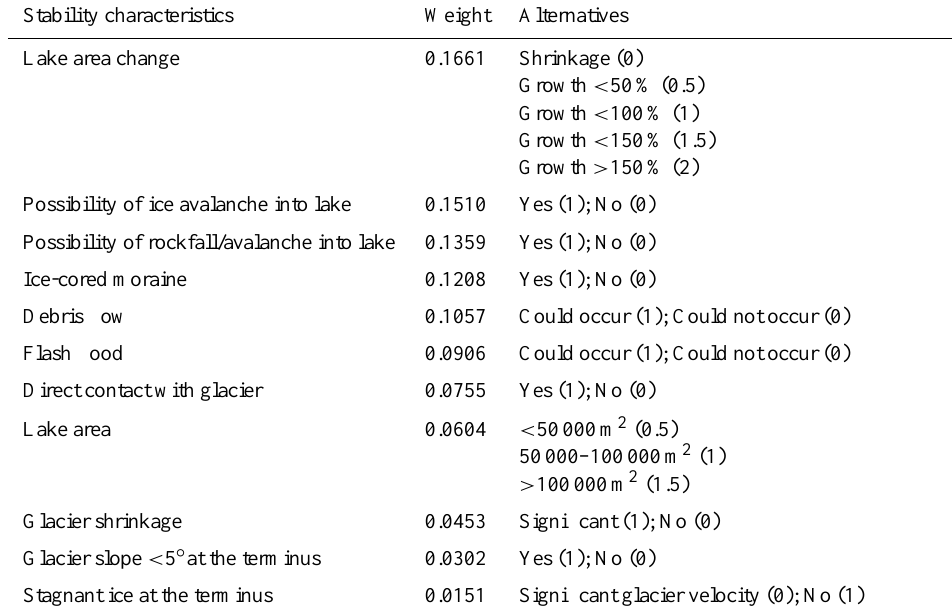
Table 6. The selected stability characteristics and their weights defined by Bolch et al.